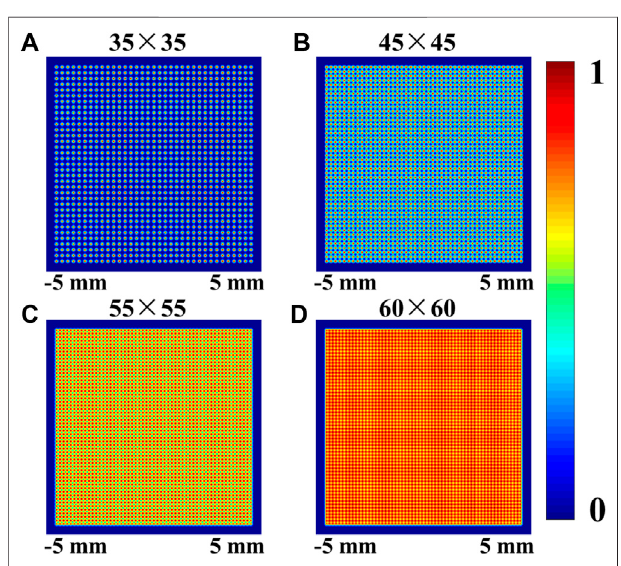
FIGURE 4 | Intensity distribution of the Gaussian lattice with the same beam size and different numbers of arrays. (A) 35×35 array; (B) 45×45 array; (C) 55×55 array; (D) 60×60